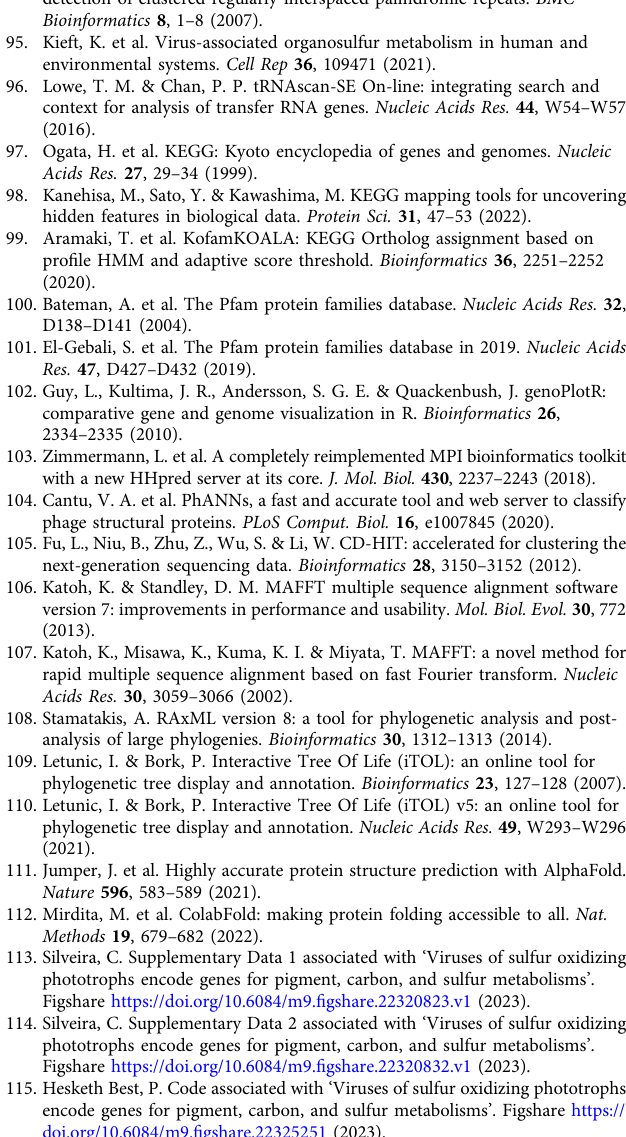
Figshare https://doi.org/10.6084/m9. fi gshare.22320823.v1 (2023). 114. Silveira, C. Supplementary Data 2 associated with ‘ Viruses of sulfur oxidizing phototrophs encode genes for pigment, carbon, and sulfur metabolisms ’ . Figshare https://doi.org/10.6084/m9. fi gshare.22320832.v1 (2023). 115. Hesketh Best, P. Code associated with ‘ Viruses of sulfur oxidizing phototrophs encode genes for pigment, carbon, and sulfur metabolisms ’ . Figshare https:// doi.org/10.6084/m9. fi gshare.22325251